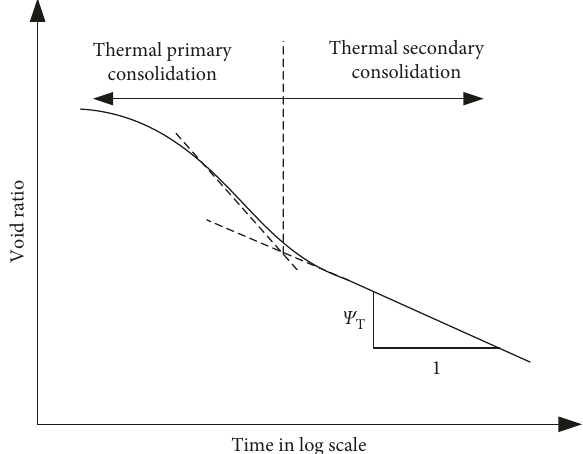
Figure 1: Definition of the thermal creep coefficient.